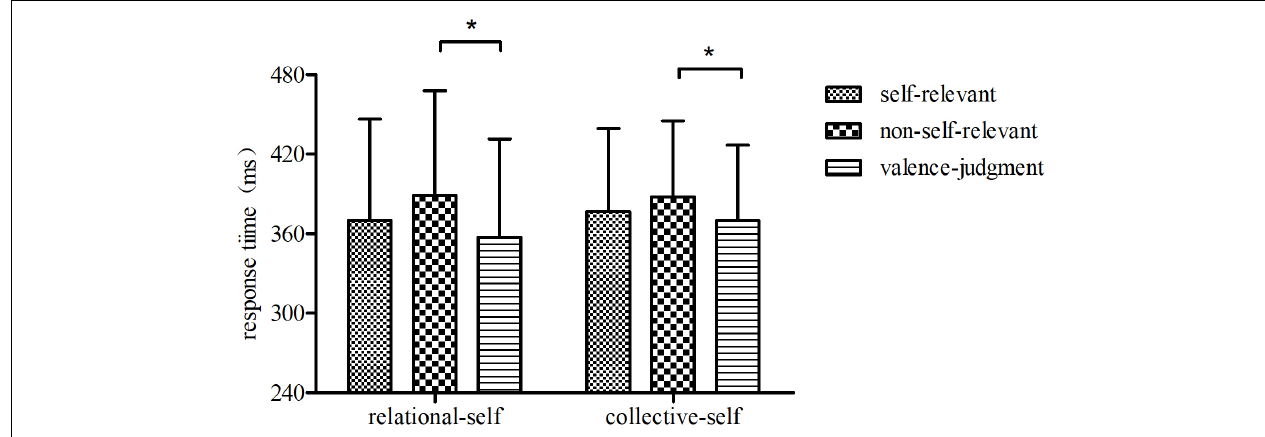
FIGURE 3 | Response times during different judgment processing. Error bars denote standard errors. ∗ p <